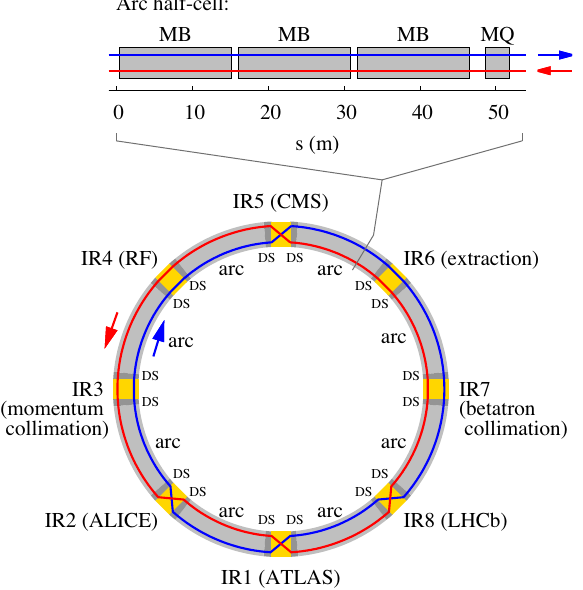
FIG. 1. Illustration of the LHC layout, showing the different insertion regions (IRs — yellow), dispersion suppressors (DS — dark gray) and arcs (gray). Each of the eight arcs consists of 23 cells. A cell is made up of two 53.45 m long half-cells (see top), which are composed of three bending dipoles (MBs), one quadrupole (MQ) and corrector magnets (not shown). The two counterrotating beams are represented by the blue line (beam 1) and the red line (beam 2), respectively. The beams are crossing each other in four interaction